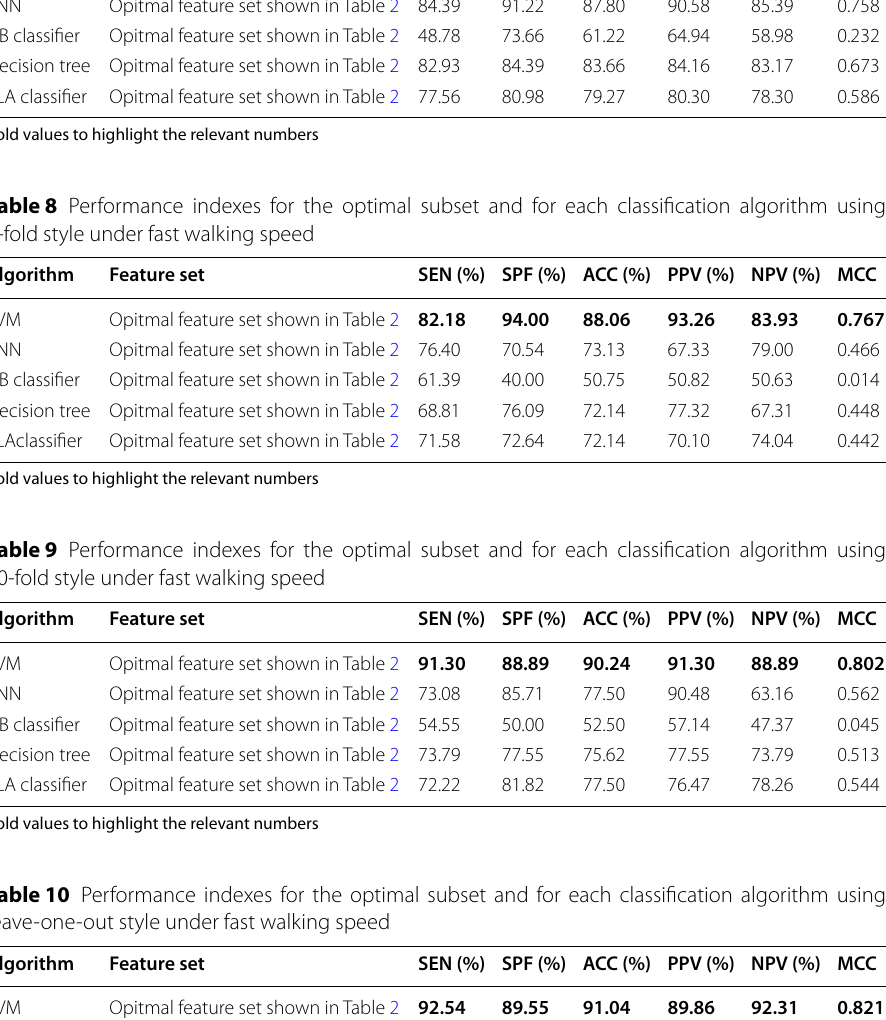
Table 7 Performance indexes for the optimal subset and for each classification algorithm using leave-one-out style under normal walking speed Algorithm